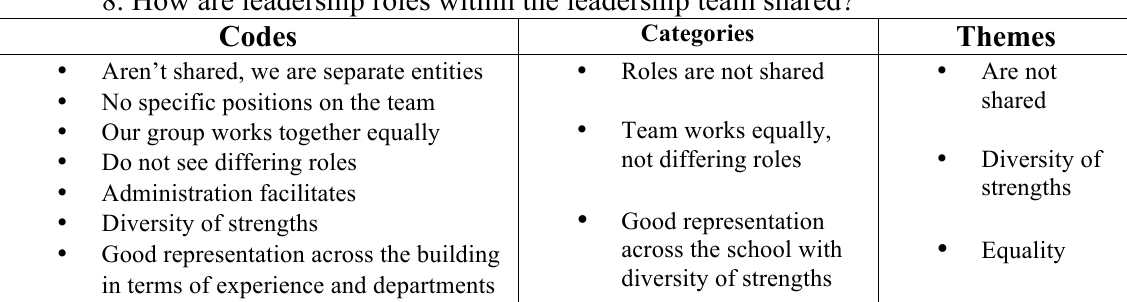
Leadership Team Members’ Question Eight and Coding 8. How are leadership roles within the leadership team